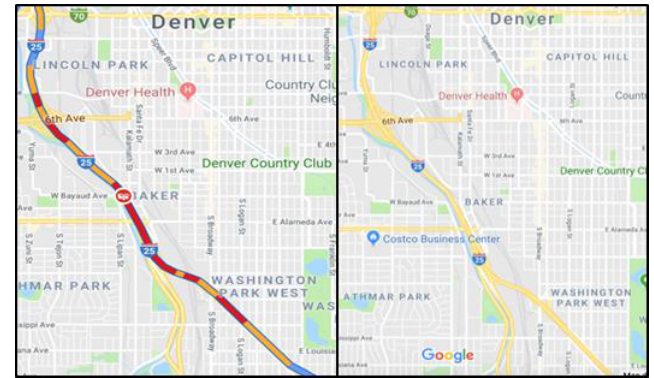
Figure 5. The segment of the real road network in Denver County.